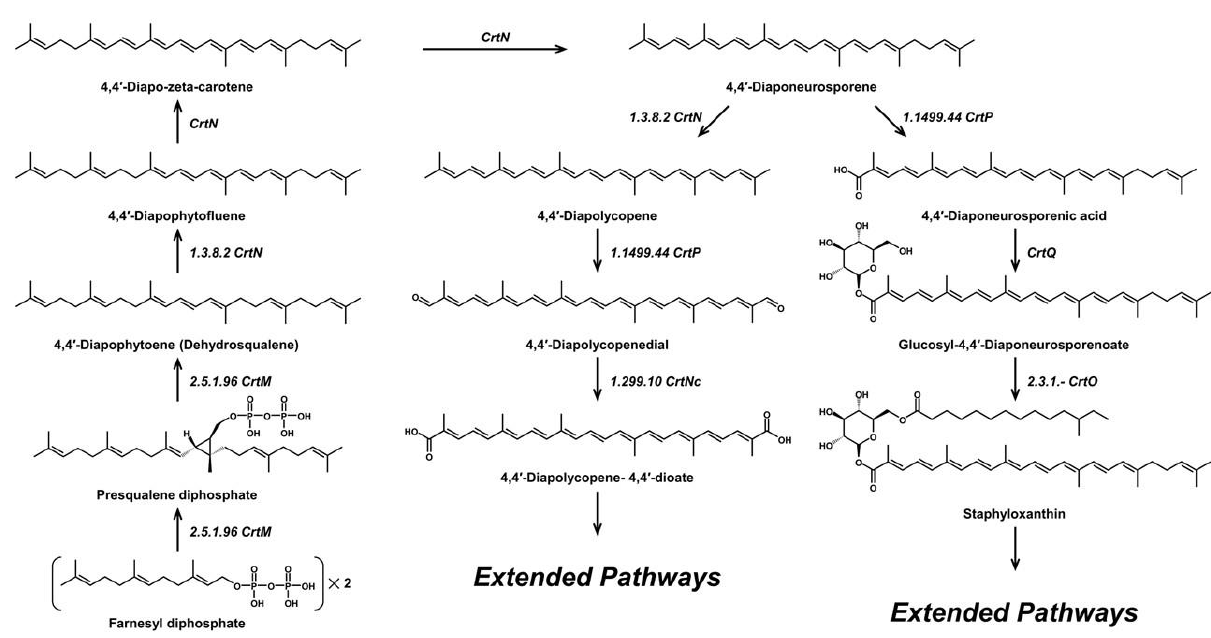
Figure 3. Biosynthetic pathway of 4, 4′ -diapocarotenoids. CrtM: 4, 4′ -Diapophytoene synthase. CrtN: 4, 4′ -Diapophytoene desaturase. CrtP: 4, 4′ -Diaponeurosporene oxidase. CrtNc: 4, 4′ -diapolycopene aldehyde oxidase. CrtQ: 4, 4′ -diaponeurosporenoic acid glycosyltransferase. CrtO: Glycosyl- 4,4′ -diaponeurosporenoate acyltransferase.